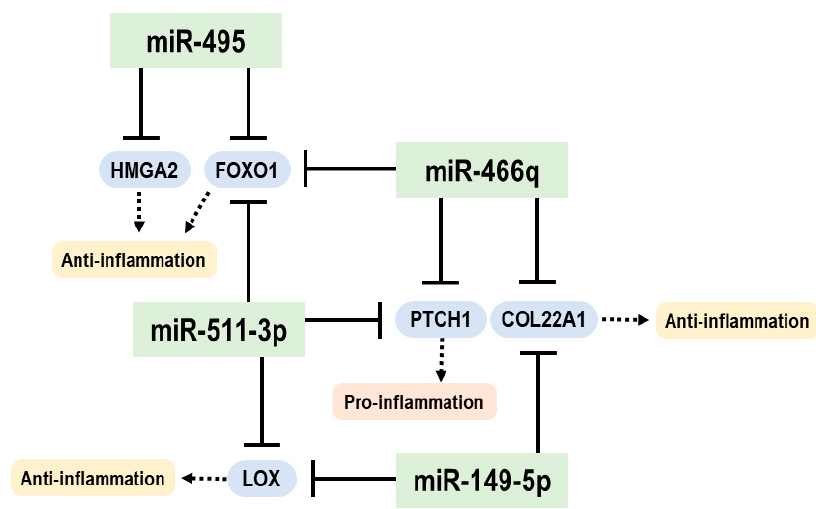
Figure 9. Graphical summary for a hypothetical model proposed in this study. A pool of distinct miRNAs such as miR-149-5p, miR-466q, miR-495, and miR-511-3p upregulated in the IEC of the sepsis mice may play roles in mediating anti- and pro-inflammatory responses by suppressing expression of their putative targets (e.g., LOX , COL22A1 , PTCH1 , FOXO1 , and HMGA2